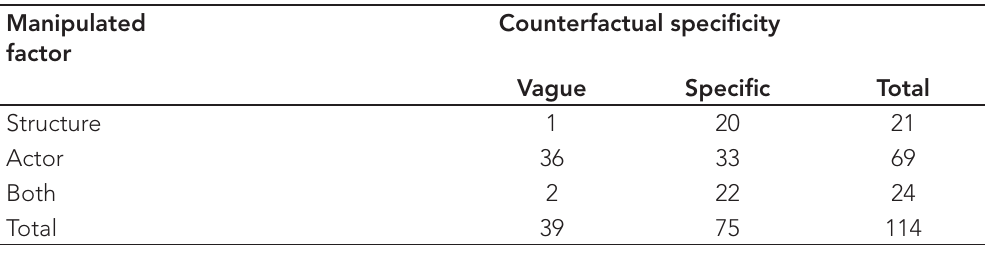
Table 3: Specificity of counterfactuals according to manipulated factor Manipulated factor